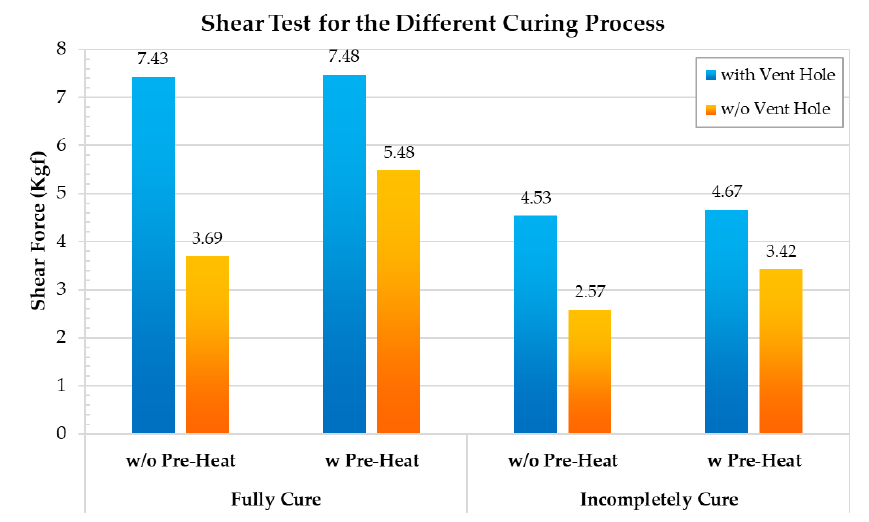
Figure 7. The shear test for discussing the degree of curing and the pre-heat condition. To improve the maximum shear force of the hermetic MEMS package, additional tests were performed while controlling for the degree of curing and the pre-heat conditions,